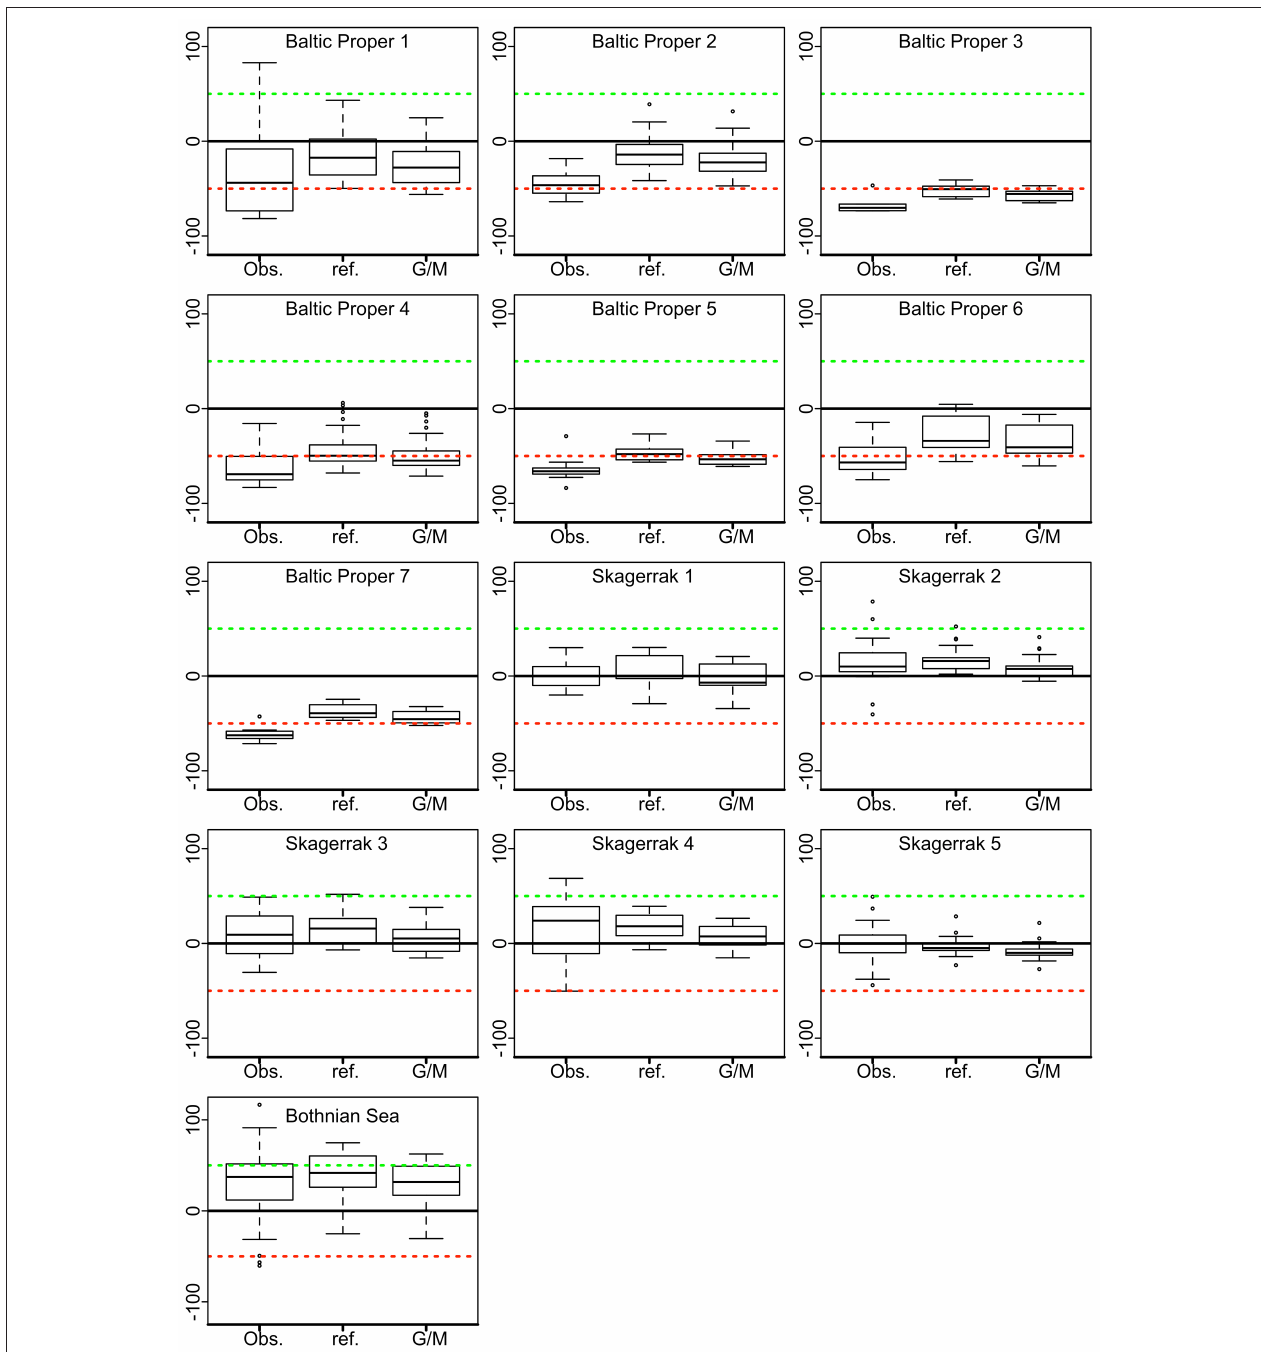
FIGURE 7 | Boxplots of the % differences to the Good/Moderate (G/M) thresholds of Secchi depth, Z SD for the respective water bodies within the WFD or the MSFD. The solid line denotes the G/M level for Z SD ; the upper dashed green line 50% above; and the lower dashed red line 50% below the Z SD threshold. The boxes for the different sub-areas represent observed Z SD (Obs), modeled Z SD with Chl-a concentrations set to the respective reference value (ref) and with Chl-a concentration set to the G/M value for Chl-a. The horizontal lines in the boxplots are the median values, horizontal edges the 25th and 75th percentiles, the whiskers indicate the min and max observations within 10th and 90th percentiles, and open circles represent